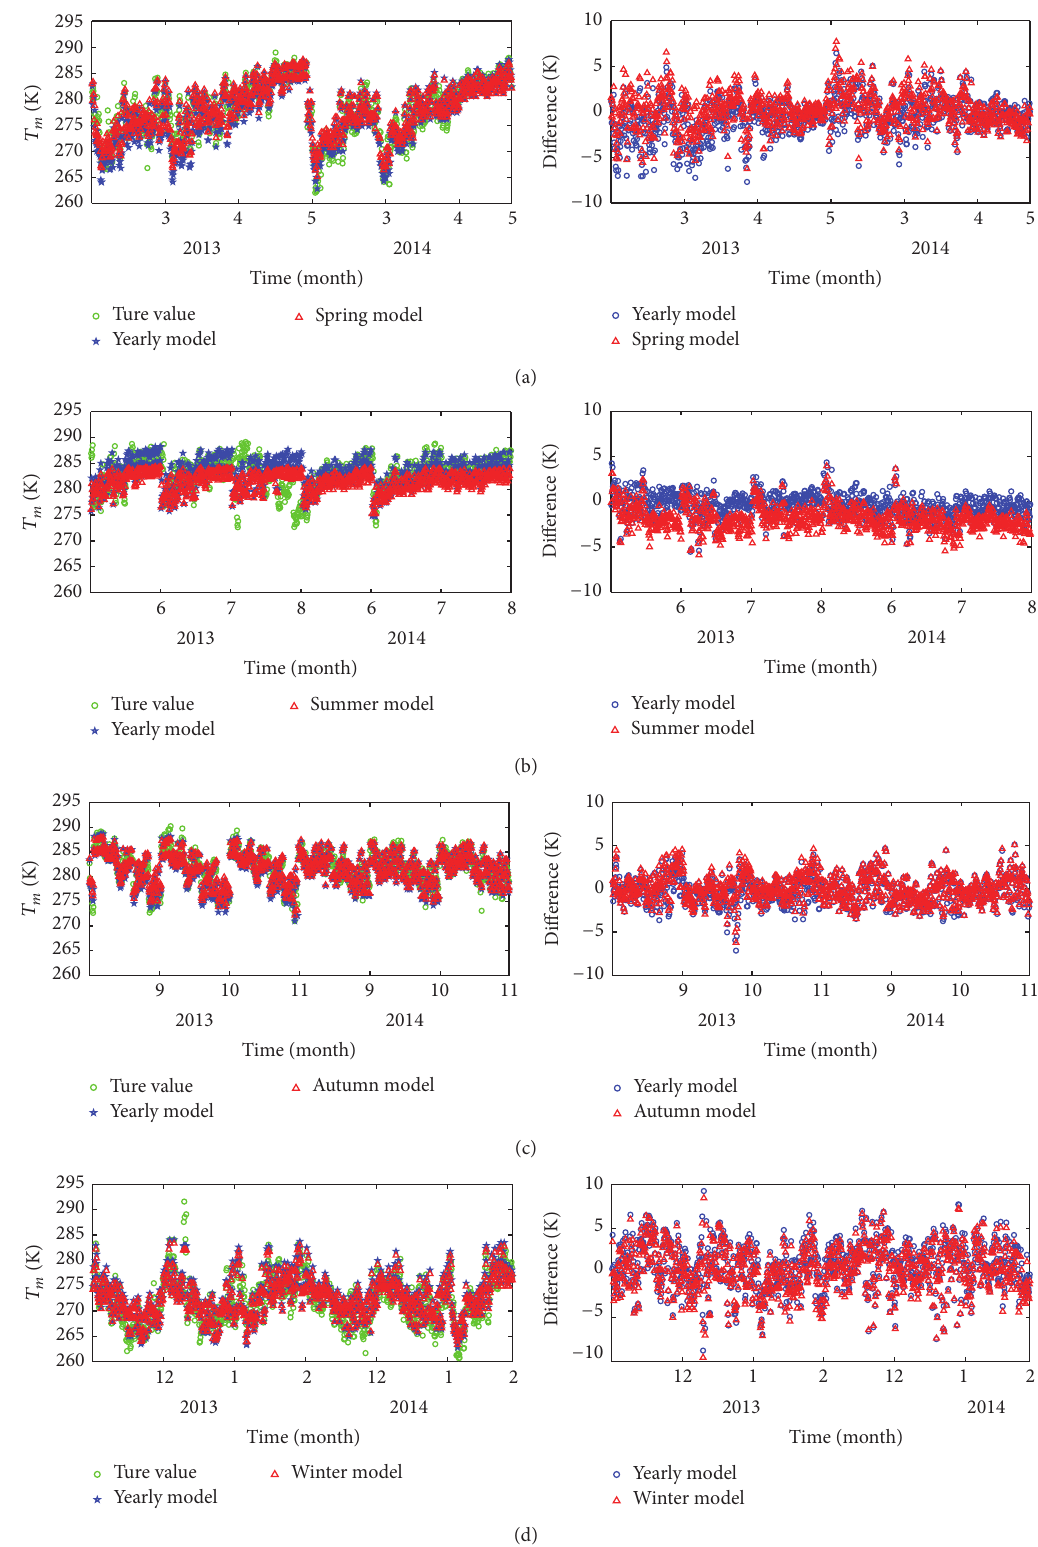
Figure 7: Comparison of the 𝑇 𝑚 time series predicted using the four seasonal two-factor RTMs, yearly RTM, and the 𝑇 𝑚 truth (left panes) and the differences of the seasonal and yearly RTMs from the truth (right panes) in (a) spring, (b) summer, (c) autumn, and (d)